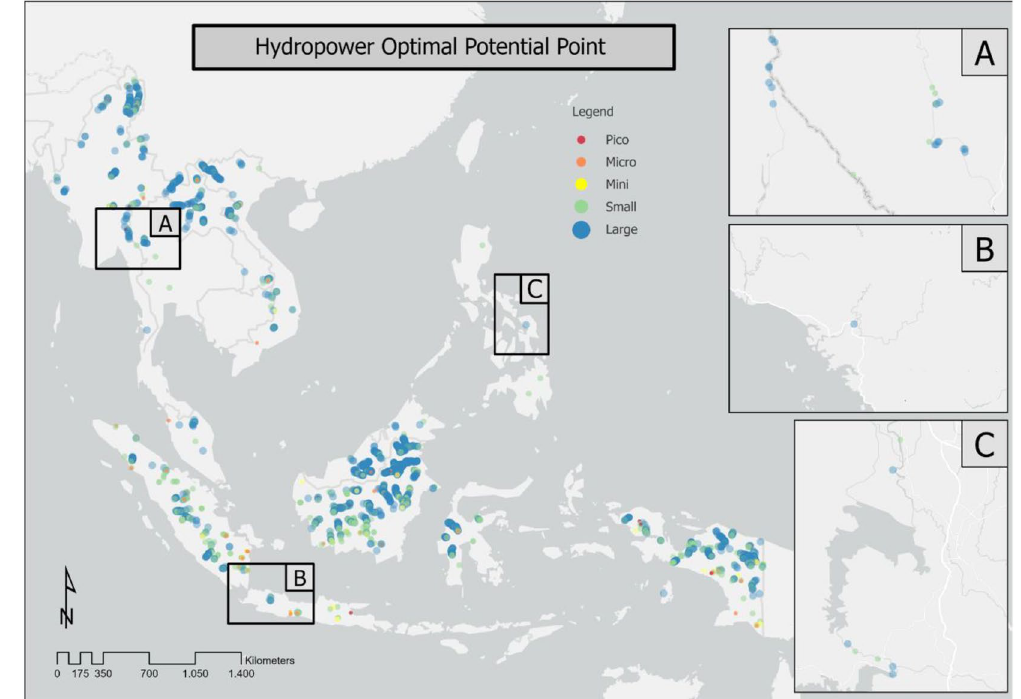
Figure 5. Potential optimal points for hydropower potential in Southeast